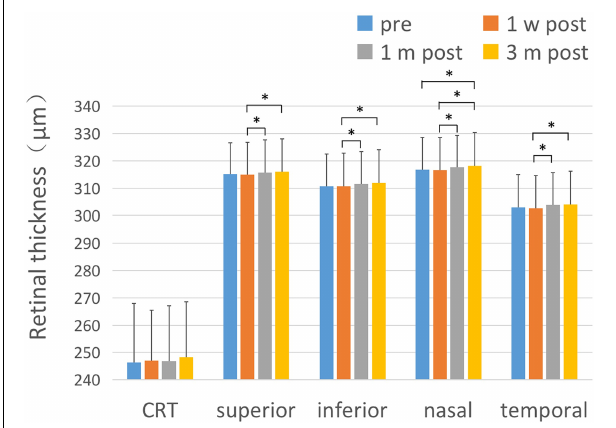
FIGURE 2 | Changes of retinal thickness with respect to CRT and the parafoveal area. After ICL implantation, the changes of retinal thickness with respect to CRT and the paracentral fovea area in each quadrant were compared. There was no significant change in CRT after ICL implantation compared with pre-operative values. The thickness of the retinal area of paracentral fovea in each quadrant at 1 month and 3 months after the operation was significantly thicker than that at 1 week after the operation, and the retinal thickness in the nasal paracentral fovea area was significantly thicker 3 months after the operation compared to pre-operative values. The short black line shows that the data at the corresponding two time points were statistically different. * P <